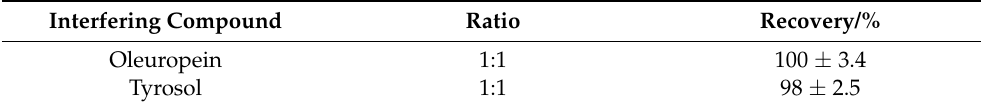
Table 5. Interference of chemically related compounds on the quantitative determination of HT 10 − 4 M. Interfering Compound Ratio Recovery/%